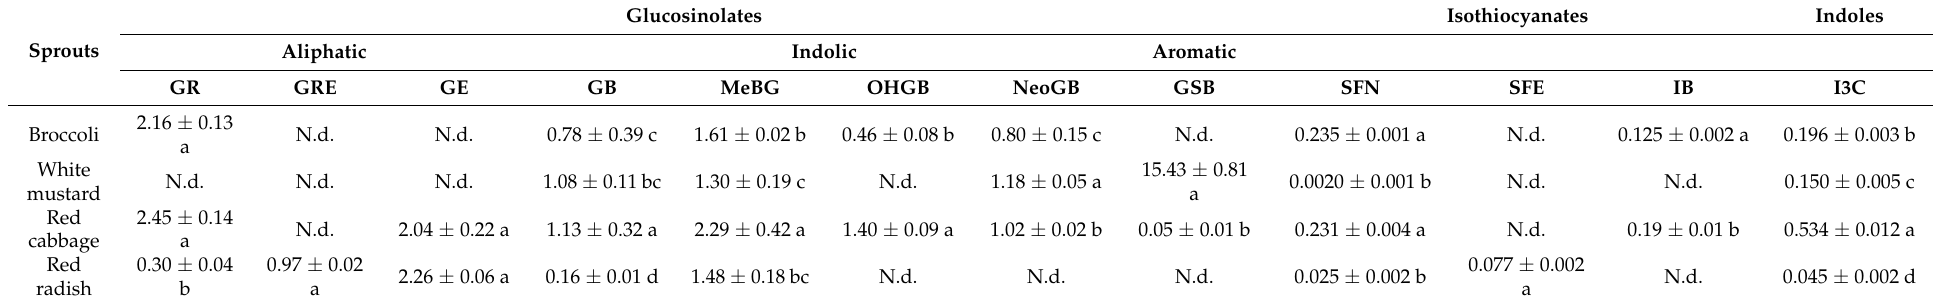
Table 2. Content (mg/100 g fw) of individual glucosinolates and glucosinolate breakdown products (isothiocyanates and indoles) in the studied sprouts. (control). Glucosinolates Isothiocyanates Indoles Sprouts Indolic